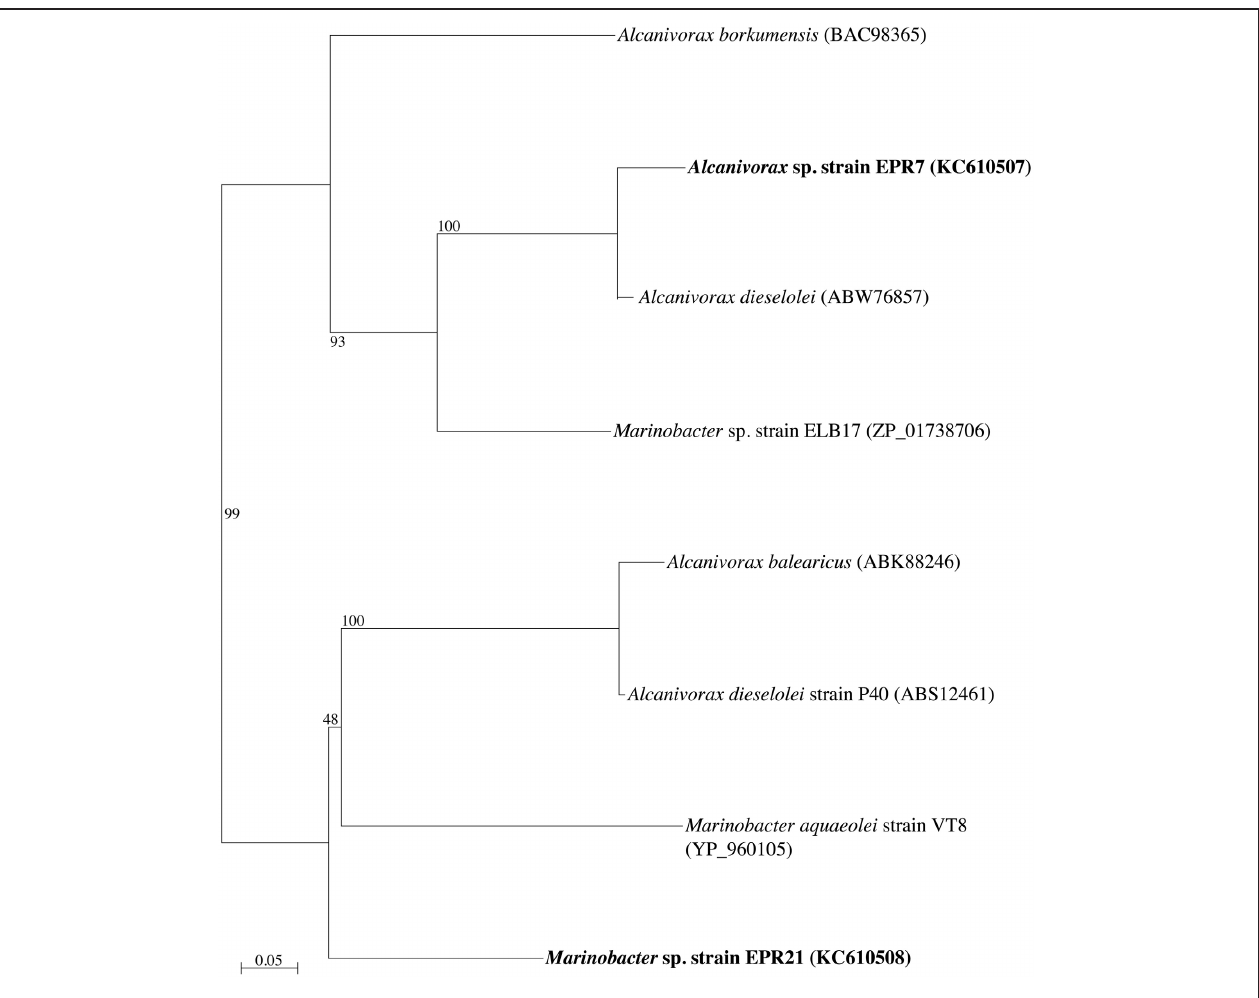
Marinobacter sp. strain EPR21 (in boldface). The tree was constructed using Phylo_Win. Bootstrap values based on 100 replications are shown as percentages at branch nodes. Bar indicates 5% estimated